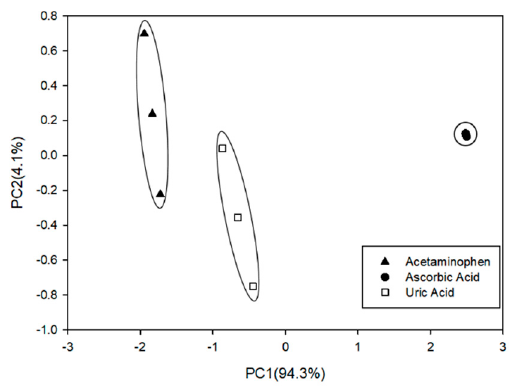
Figure 9. Score plot of the two components obtained after PCA analysis. The PCA shows three clusters across the PC1 (94.3%). These clusters correspond to the studied compounds for n = 3 replicates. These results were obtained using the sensor array chosen.